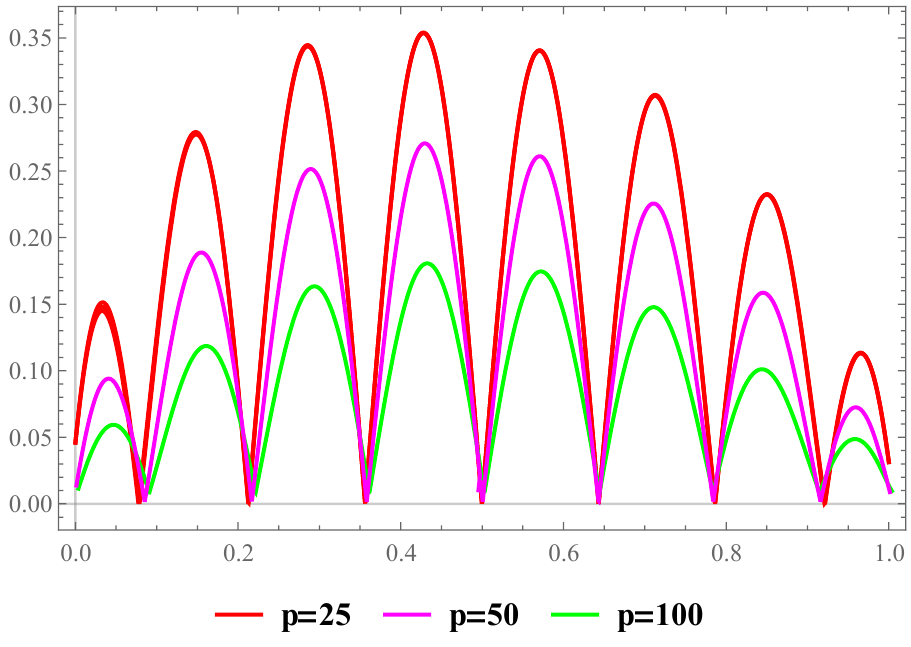
Figure 2. Maximum error of approximation for function r 1 ( u ) .